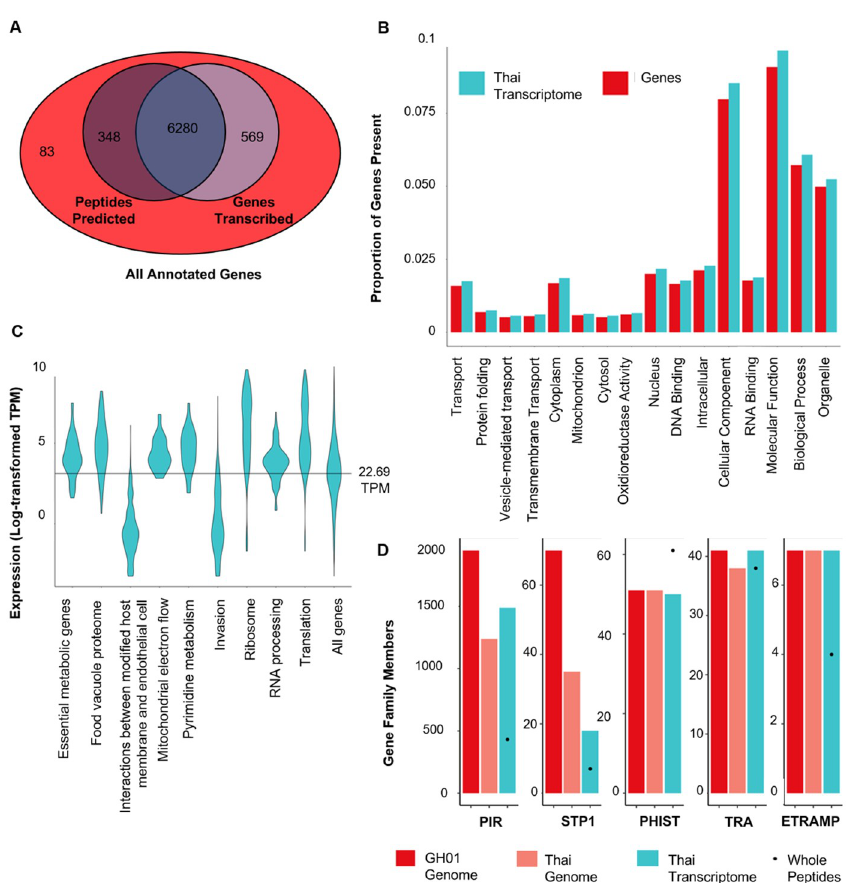
Fig 1. Gene expression within the P . ovale curtisi field sample. (A) Overlap between assembly and alignment-based methodology. Genes identified by peptide prediction on transcripts and transcript fragments are outlined in dark blue while the genes identifiable by transcription at TPM greater than or equal to 1 are in lighter blue. The red outer circle displays all annotated genes, including 83 of which were not identified by either means. (B) Proportion of genes annotated from the existing genome (PocGH01, PlasmoDB.org) compared to those found by alignment at 1 or more TPM in each of the statistically significant Gene Ontology groupings (Bonferroni-adjusted P-value < 0.05). (C) Distribution of TPM (Log transformed) per gene grouping with significantly high or low transcription in the P . ovale field sample. The line through the center represents the median of all genes. (D) Gene family repertoires. Bars represent genes above TPM 1, while points within the study bar represent whole peptides, defined as those with both a beginning and end present in the ORF.